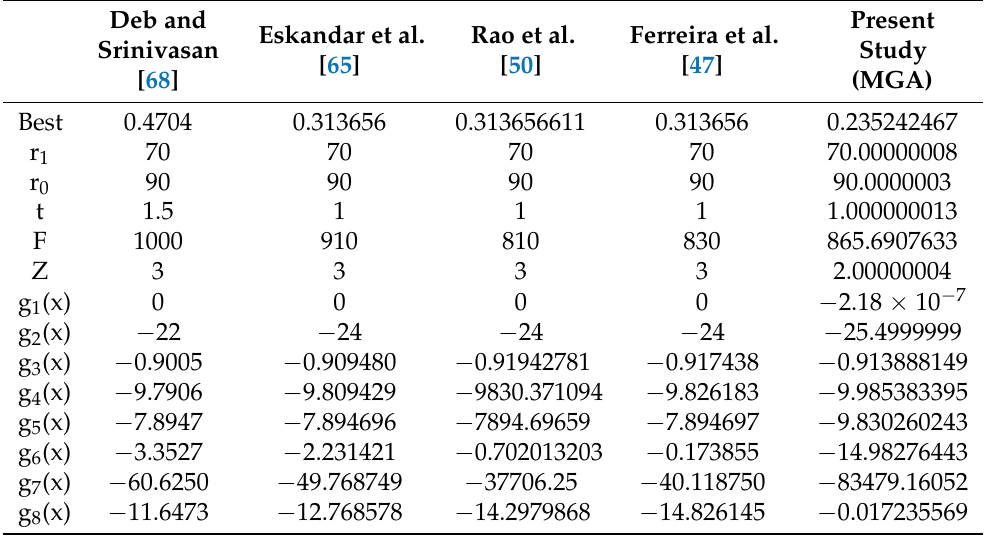
Table A11. Comparison of the best solutions for the multiple disk clutch brake design